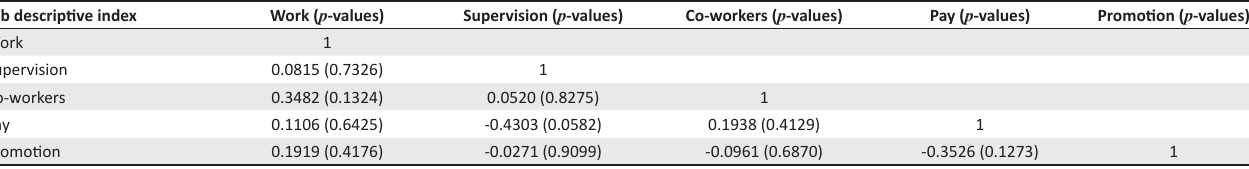
TABLE 6: Pearson’s correlation coefficients and associated p -values for the JDI instrument. Job descriptive index